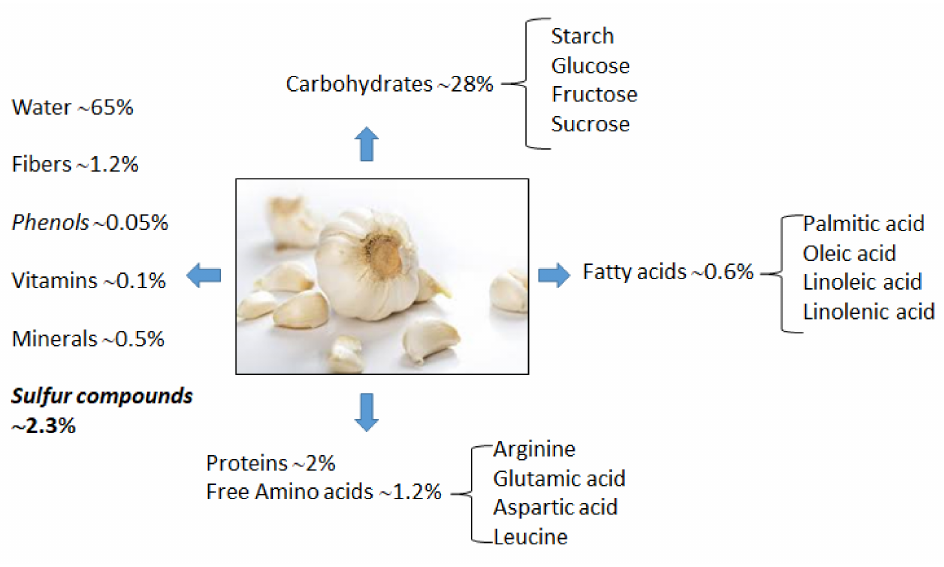
Figure 1. Fresh garlic proximate composition; data are expressed as % w / w